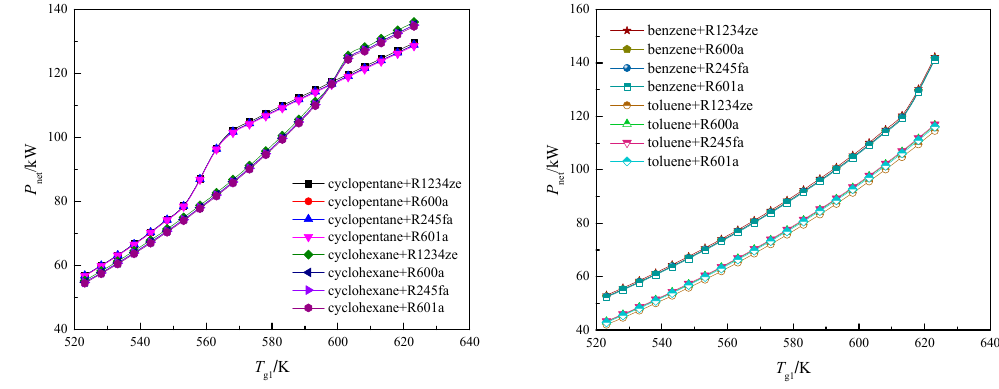
Figure 5. Effects of T g1 on the net power output.